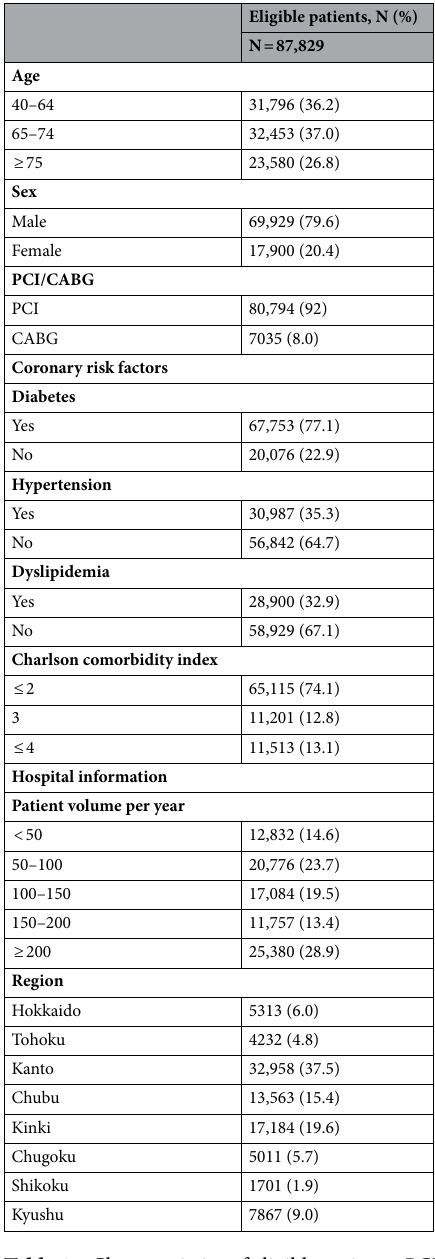
Table 1. Characteristics of eligible patients. PCI percutaneous coronary intervention, CABG coronary artery bypass